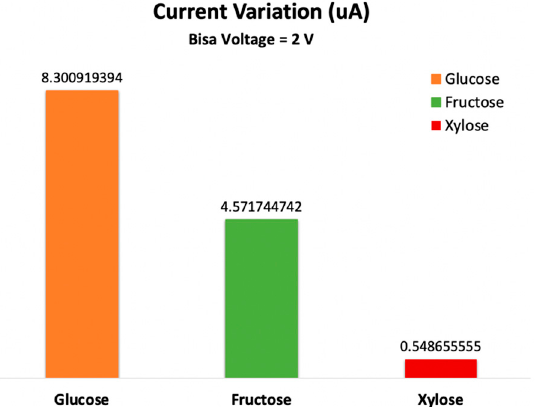
Figure 9. Change in electrical drain current for the GNR-FET due to the different types of the sugar molecules.